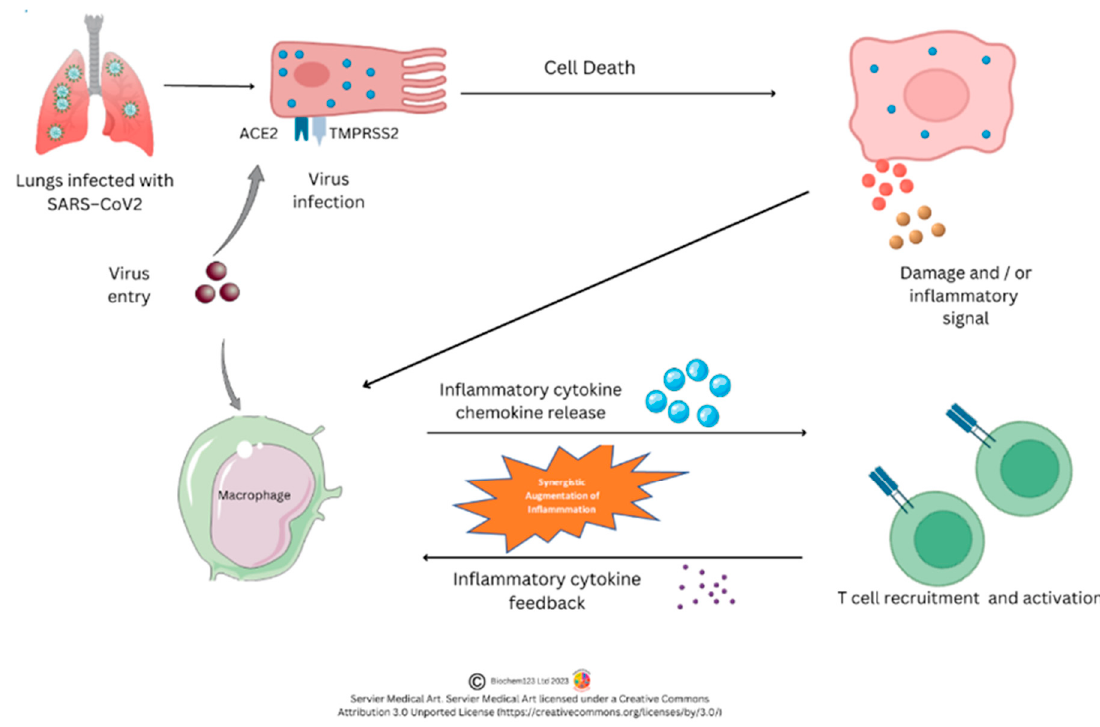
Figure 1. Overview of SARS-CoV-2 immune cell